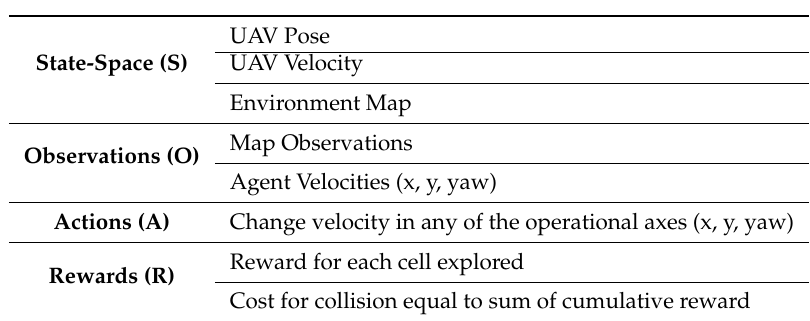
Table 2. Local Control Environment